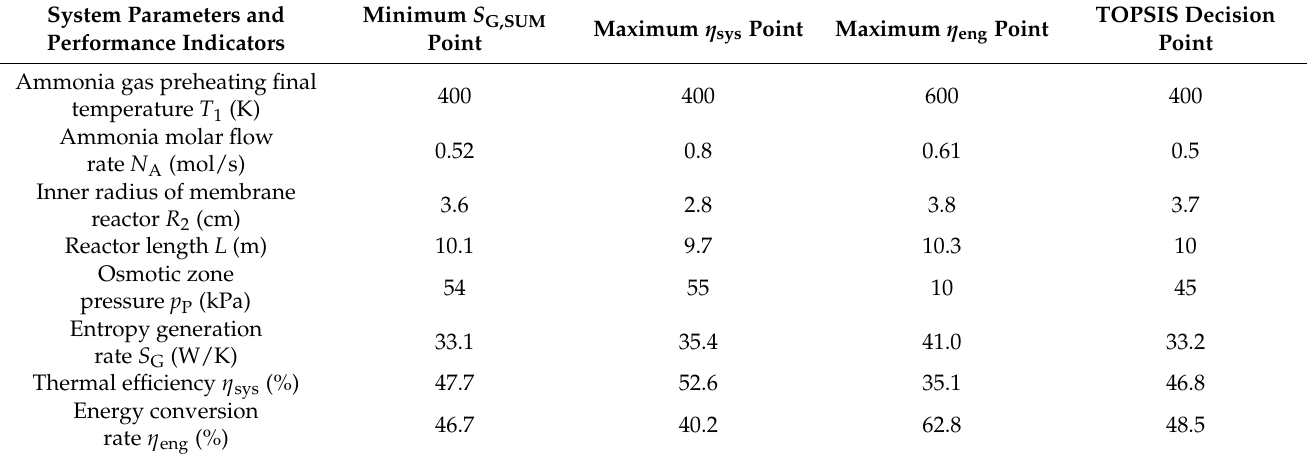
Table 2. Feature point parameters on the Pareto Front of three-objective optimization at 800 W/m 2 .